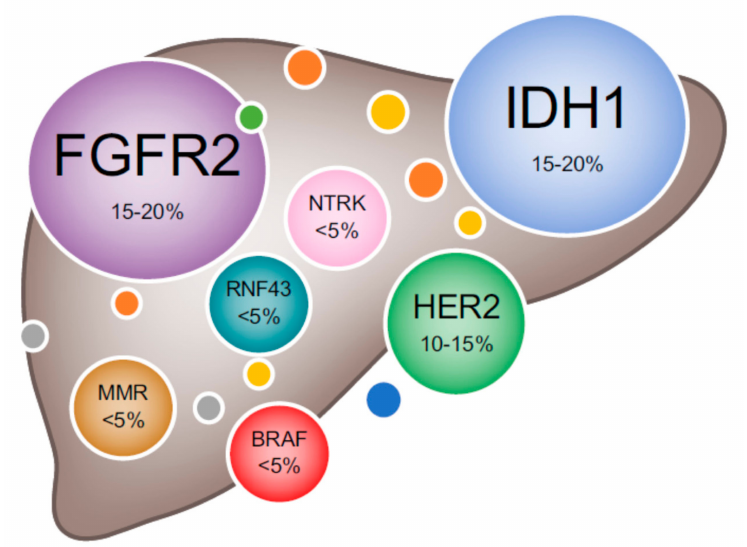
Figure 2. Schematic overview of therapeutically actionable drivers in biliary tract cancers. Abbreviations: FGFR2: Fibroblast growth factor receptor 2; HER2: Human epidermal growth factor receptor 2; IDH1: Isocitrate dehydrogenase 1; NTRK: Neurotrophic tyrosine receptor kinase; MMR: mismatch repairdeficiency.ReproducedwithpermissionfromElsevier, fromLamarca, A.etal.